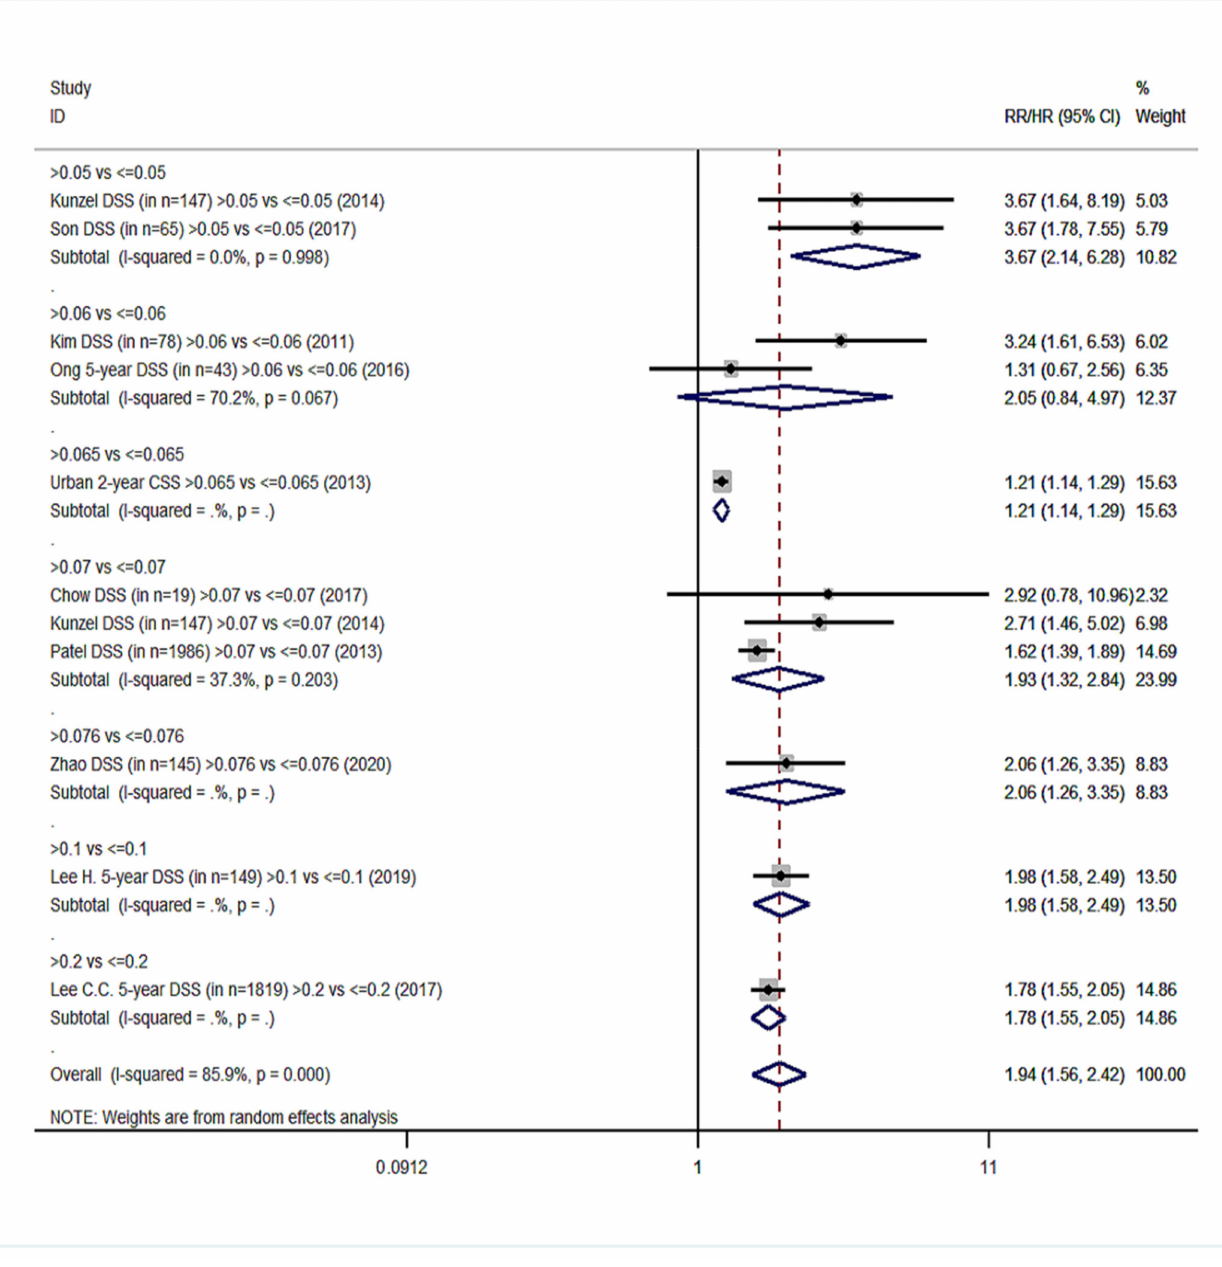
Figure 4. Forest plot demonstrating the associations between lymph node ratio (LNR) and disease- specific survival (DSS) in group YES. Apart from the overall analysis, the subanalyses by LNR cut-off values are